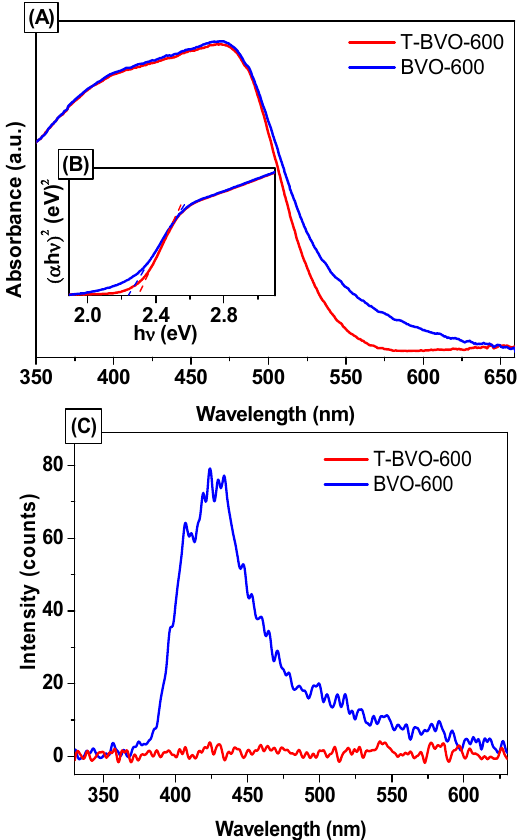
Figure 4. Ultraviolet-visible diffuse reflectance spectroscopy (UV-Vis DRS) spectra ( A ), (ah ν ) 2 –h ν curves ( B ), and photoluminescence (PL) spectra of T-BVO-600 and BVO-600 ( C ).